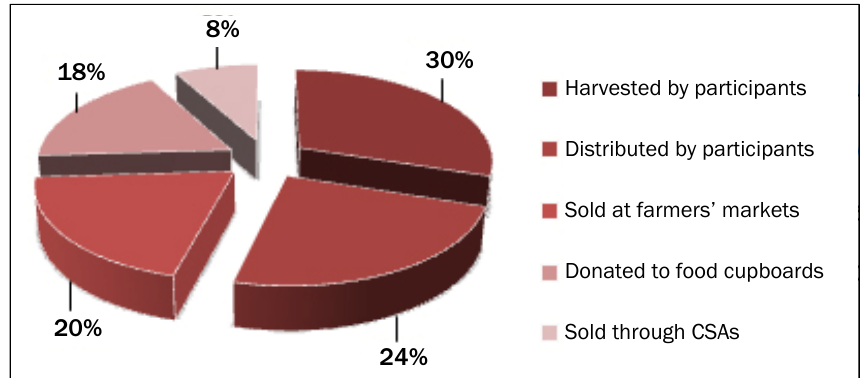
Figure 7. Modes of Urban Agriculture Produce Distribution in Philadelphia